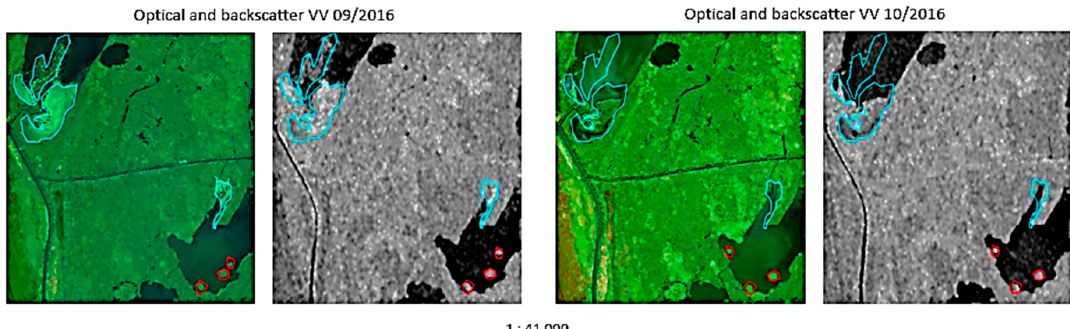
Figure 6. Identification of plaurs (macrophytes red) and aquatic macrophytes (cyan) from backscatter coefficient images (September–October 2016). RGB bands combination for the optical image.